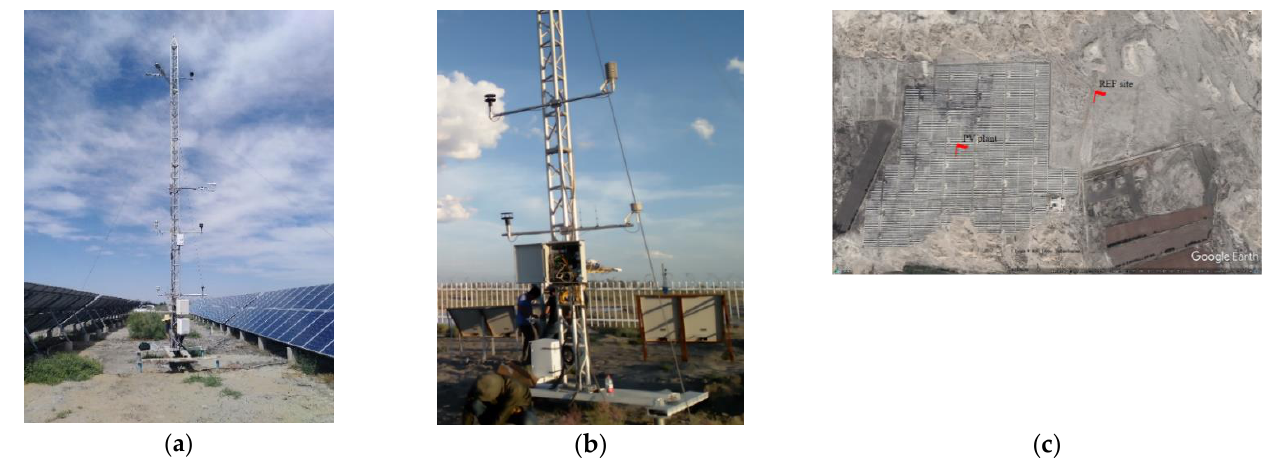
Figure 1. Photos of the monitoring sites in the PV plant ( a ) and the reference site (east to the PV plant) ( b ) in the Wujiaqu Gobi area. The map ( c ) shows the layout of the PV plant and the locations of two observation systems (from Google Earth by the end of 2018).